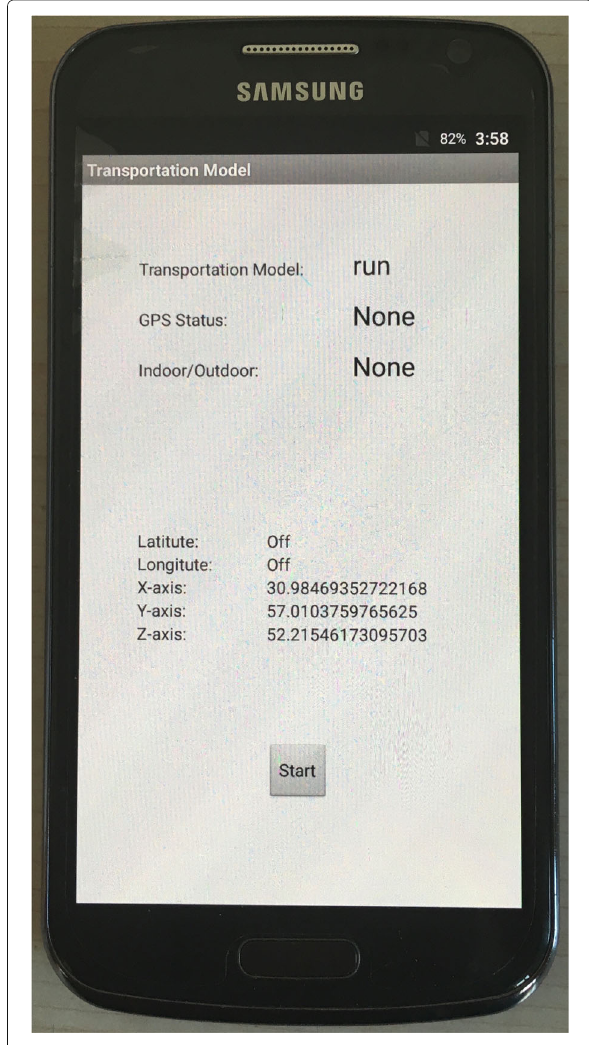
Fig. 6 Ambulation infers wrong transportation mode under Sensor Guardian’s control. Under the Randomization policy, Ambulation infers the transportation mode to be running though the device is placed still on the